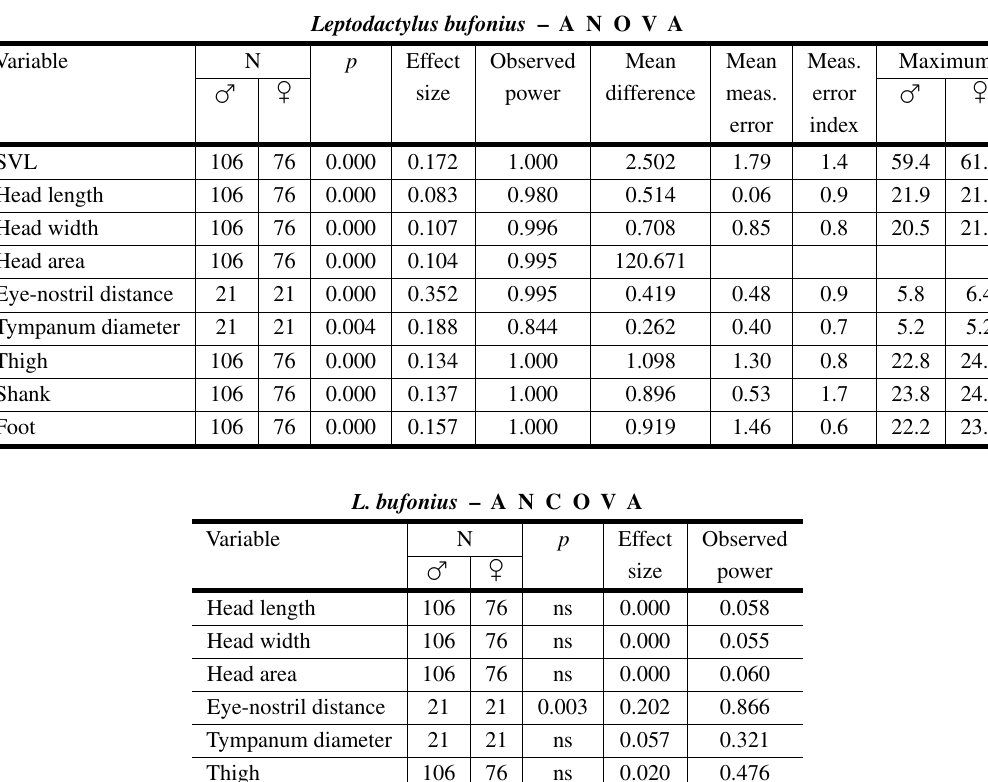
ANOVA andANCOVA results for Leptodactylus bufonius , L. troglodytes , L. furnarius , and L. gracilis data. Meas. = measurement. Negative mean difference values (bold) indicate the male values are greater than female